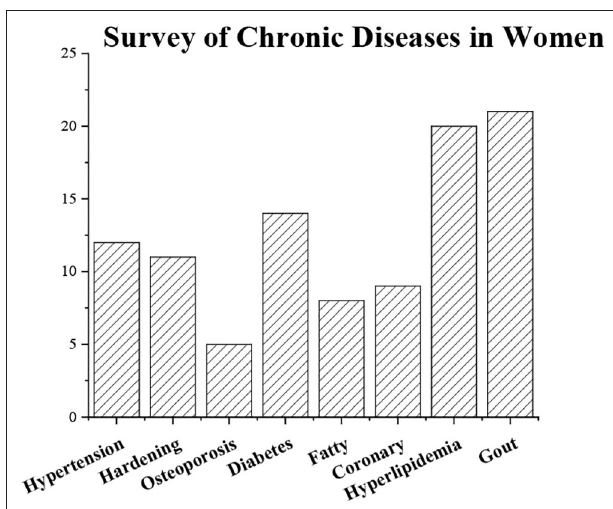
FIGURE 19 | General situation of residents’ chronic diseases